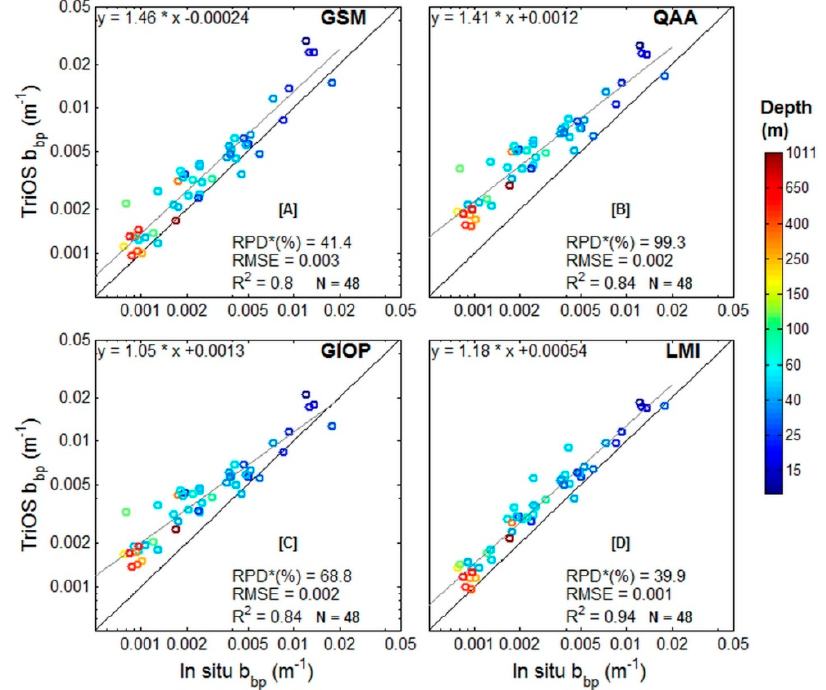
Figure 14. Comparisons between the in situ measured and modelled particle backscattering coefficient ( b bp ) at 443 nm using Remote sensing reflectance from TriOS radiometer (R rs T) (TriOS b bp ) obtained with: Garver-Siegel-Maritorena (GSM01) ( A ), Quasi-Analytical Algorithm (QAA) ( B ), Generalized IOP (GIOP) ( C ) and Linear Matrix Inversion (LMI) ( D ) (Number of samples = 47). Axes in log scale.